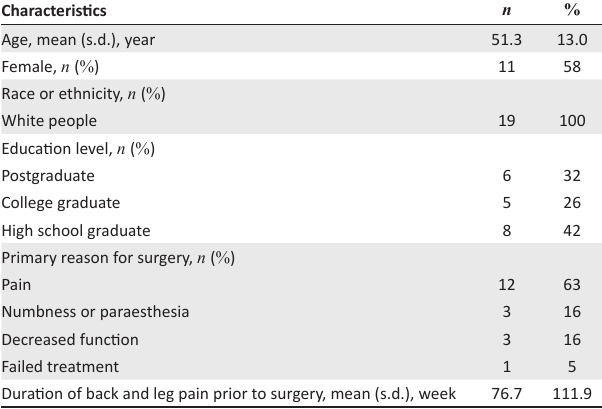
TABLE 2: Participant demographics n = 19.